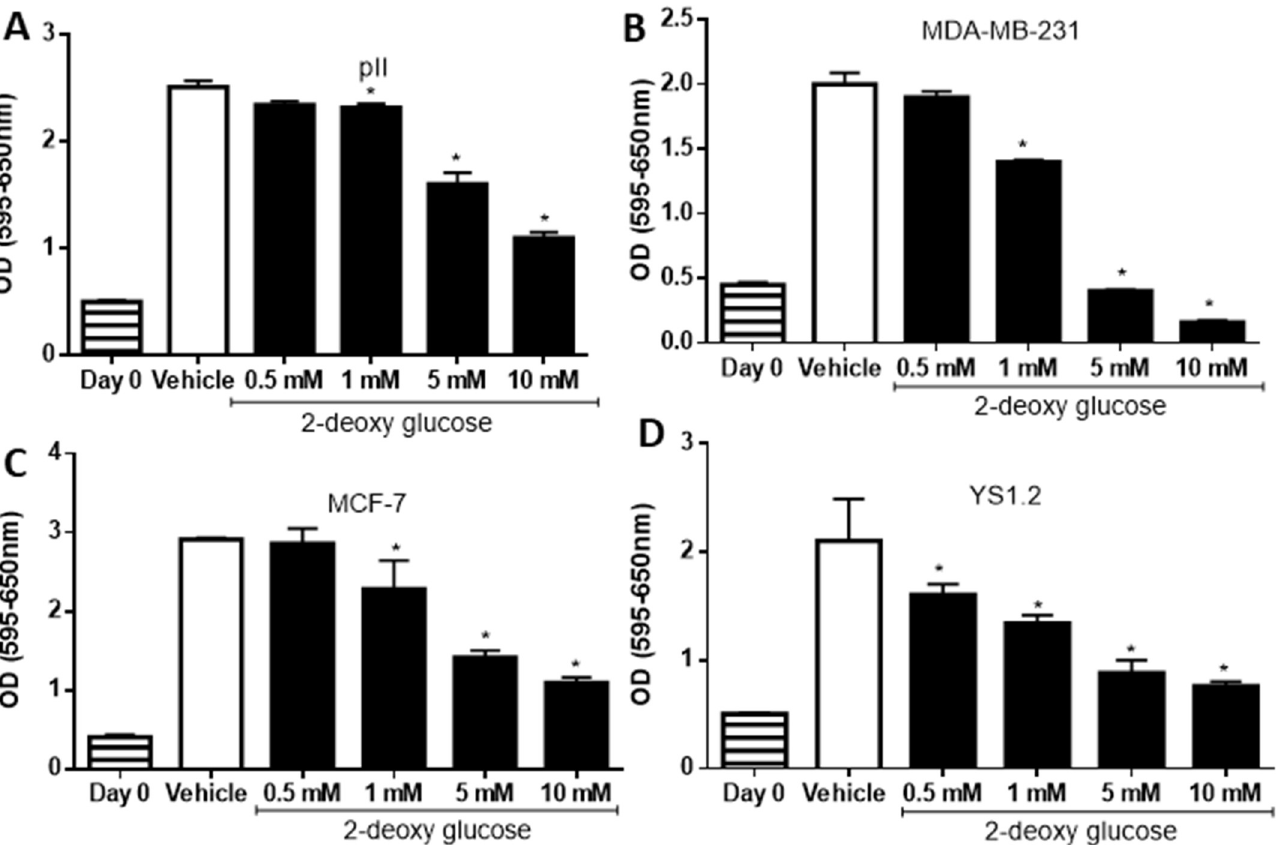
Fig 6. Effect of 2-deoxy glucose on cell proliferation. Proliferation of the cell lines indicated was measured after 4 days of exposure to either vehicle or various concentrations of 2-DG, using the MTT assay. Histobars represent means ± SEM of at least 3 independent experiments. � denotes significant difference from vehicle-treated cells, with p <